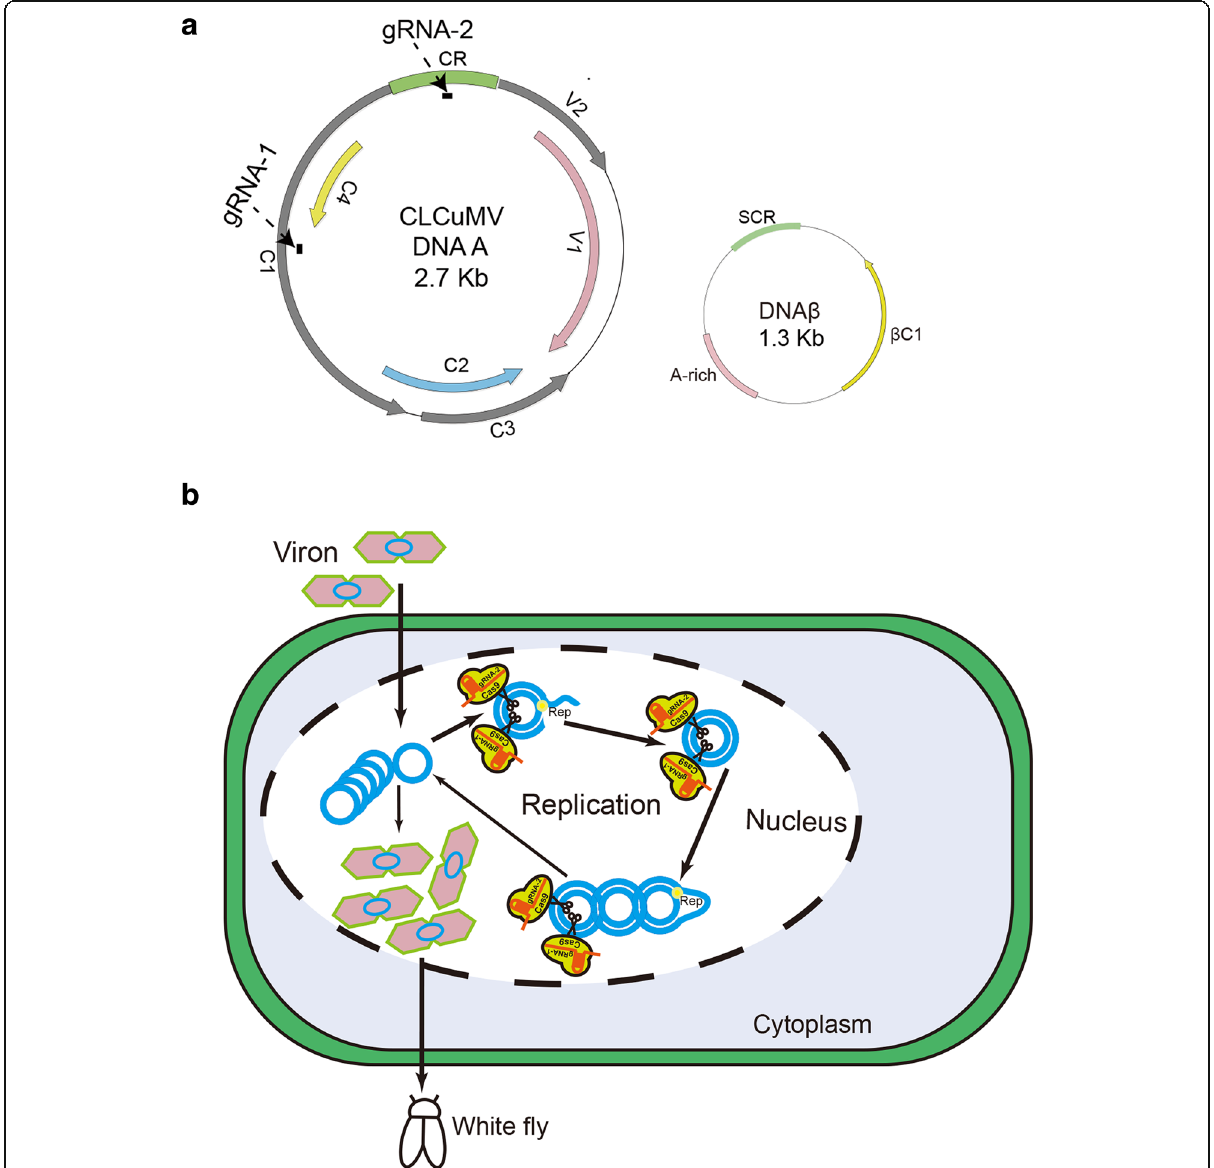
Fig. 1 Schematic diagrams of constructions of CLCuMuV and CLCuMuB infectious clones and CRISPR/Cas9 system-mediated virus resistance in plants. a Genome organization of the wild-type CLCuMuV and CLCuMuB and sgRNA target sites. The ORFs are represented by filled arrows, CR, SCR and A-Rich region are represented by filled boxes. The two target sites are represented by dashed arrowheads. b Schematic representation of CRISPR/Cas9 system-mediated CLCuMuV resistance. Once the virus infects a plant cell, it enters the cell nucleus where it replicates to produce more viruses. Some of them are packaged into virus, which can be transmitted into other plants by